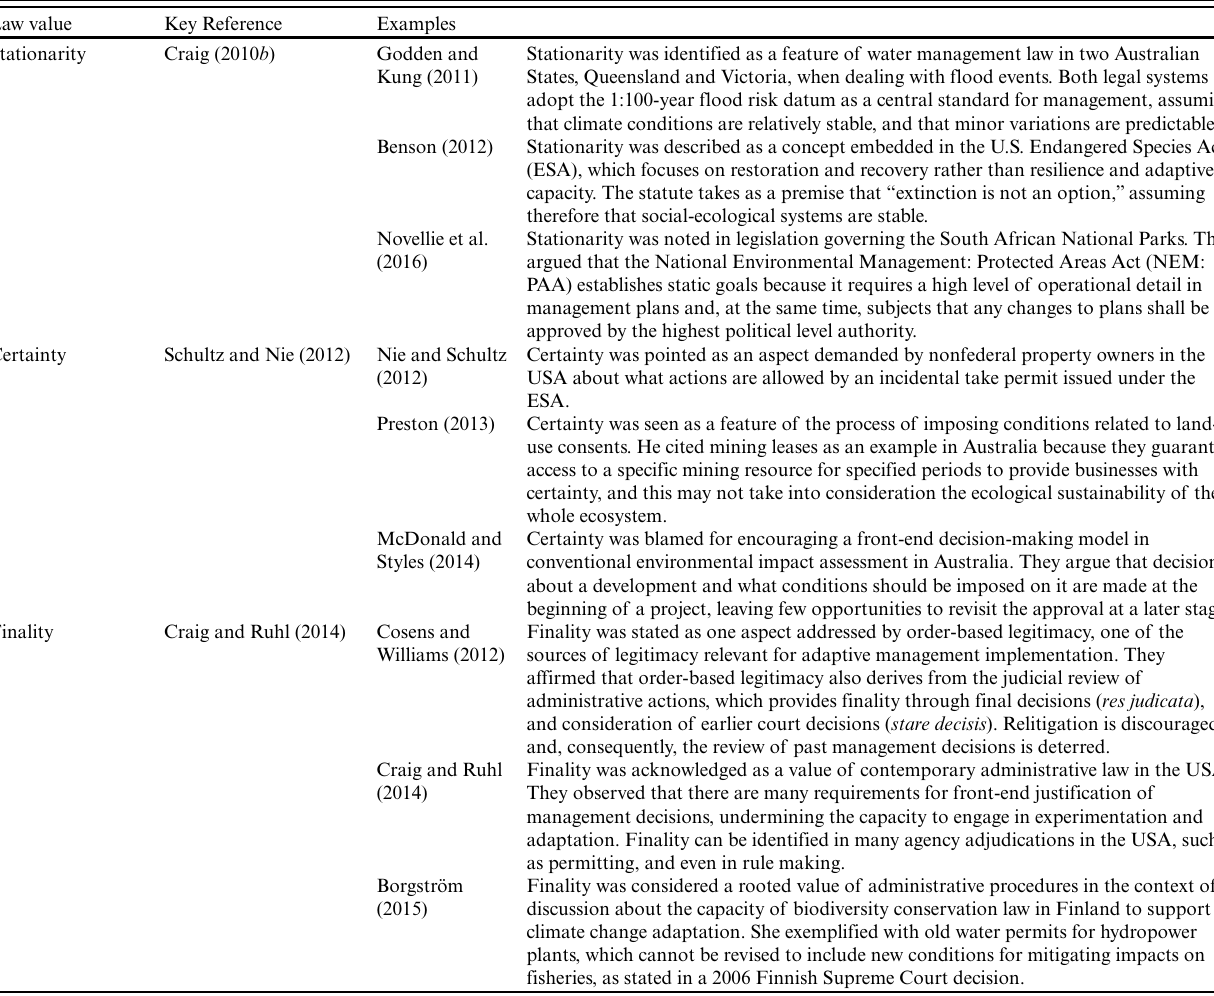
Table 3 . Law values hindering the design and implementation of adaptive